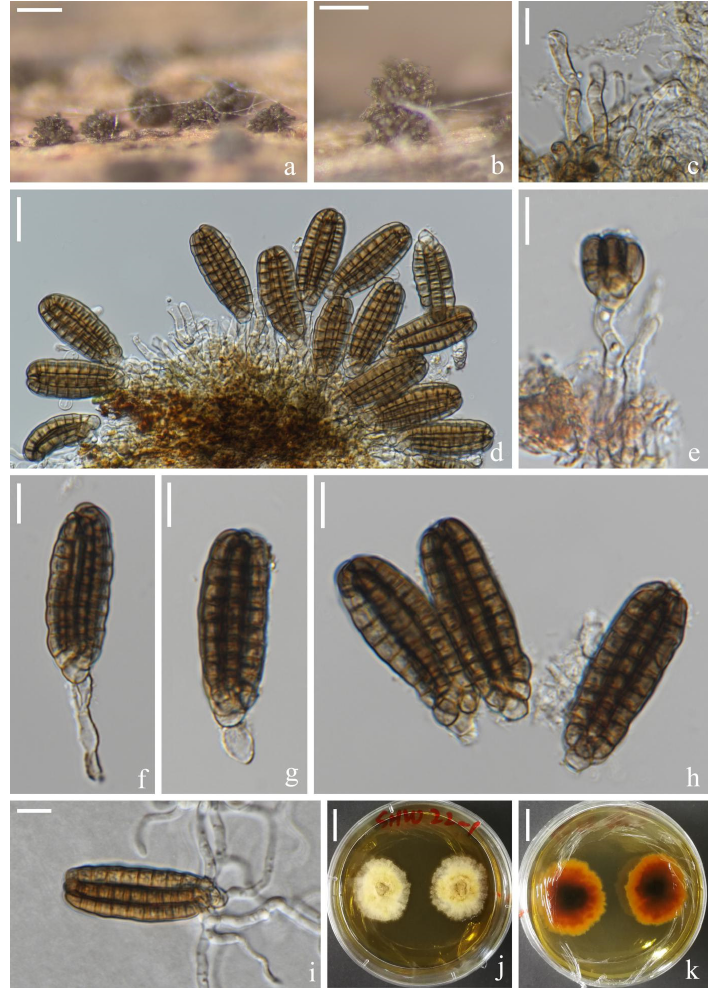
Figure 2. Dictyocheirospora chiangmaiensis (MFLU 22–0199, holotype). ( a , b ) Colonies on the substratum. ( c ) Conidiophores. ( d ) Conidiomata with conidiophores. ( e – g ) Conidiogenous cells with conidia. ( h ) Conidia. ( i ) Germinating conidium. ( j , k ) Culture colonies on MEA, reverse (left) and obverse (right). Scale bars: ( a ) 200 μ m, ( b ) 100 μ m, ( c , e – i ) 10 μ m, ( d ) 20 μ m and ( j , k ) 1 cm. MycoBank number: MB